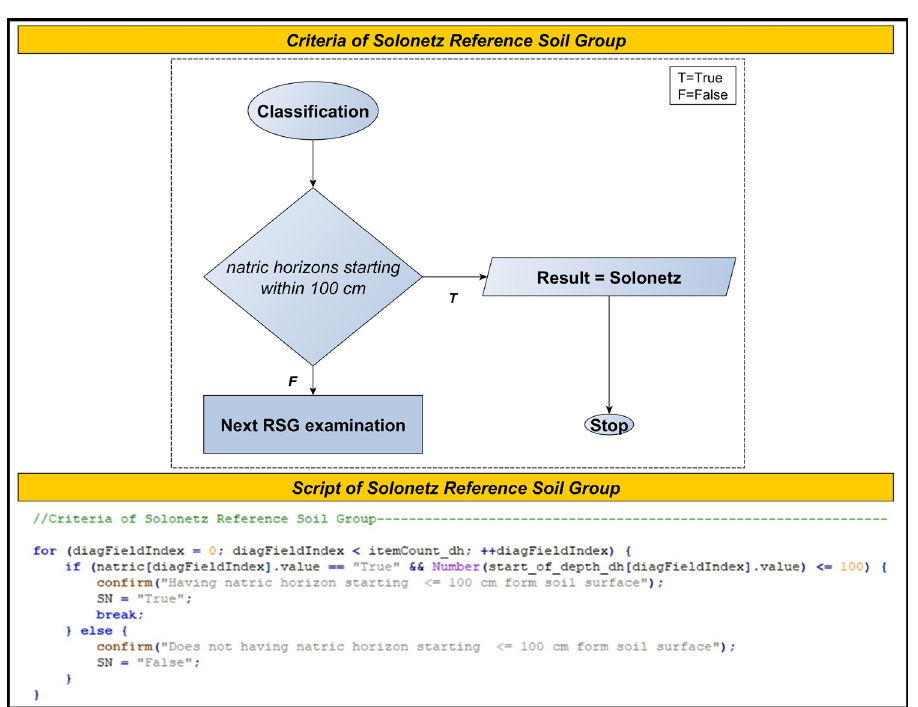
Figure 21: Example script for automatic RSG